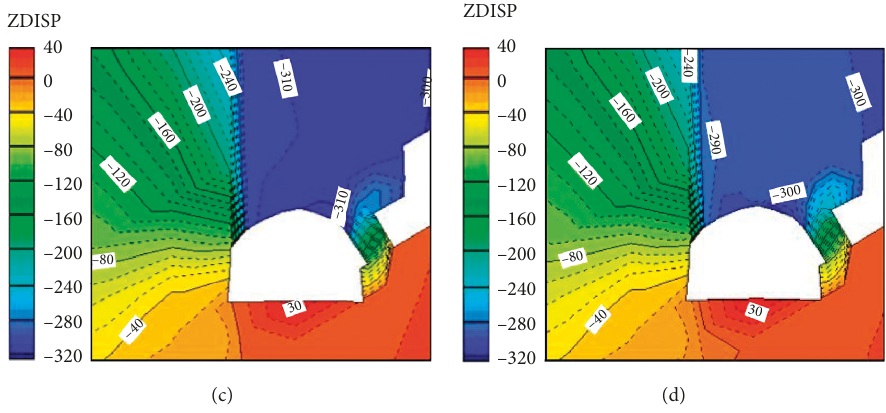
Figure 22: Vertical displacement nephograms of different concrete materials: (a) C40, (b) C50, (c) C60, and (d) LC50.